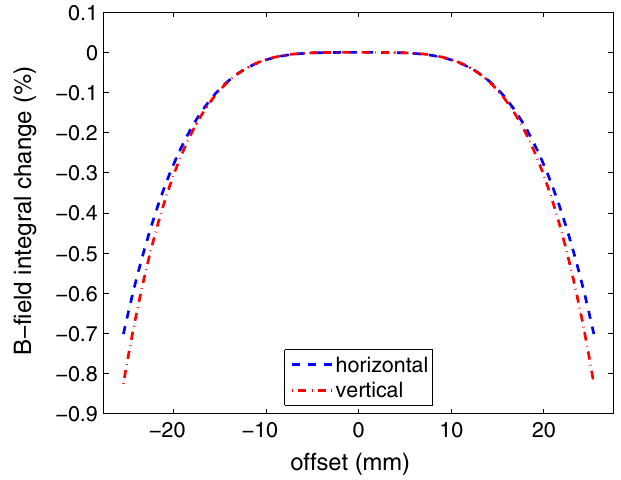
FIG. 4. (Color) Uniformity of the B-field integral for beam scanner coils. The quantity plotted is I ð x; 0 Þ = I ð 0 ; 0 Þ (cid:5) 1 and I ð 0 ; y Þ = I ð 0 ; 0 Þ (cid:5) 1 , where I ð x; y Þ (cid:6) y ¼ 0 offset corresponds to the center of the beam pipe.